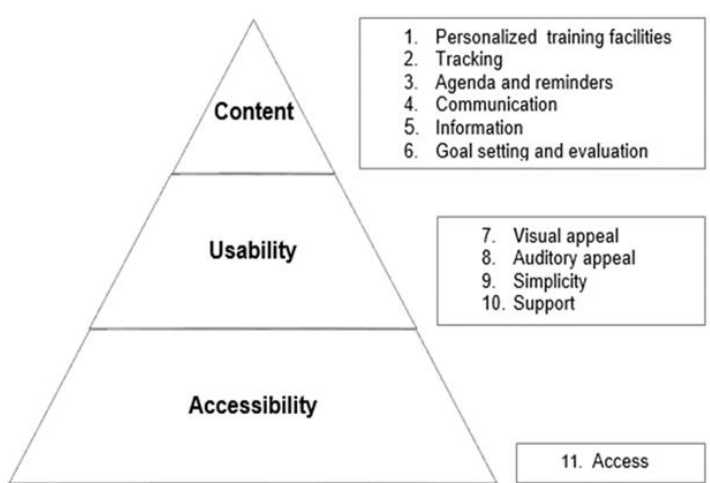
Figure 1. Key themes end-user requirements for e-health interventions in stroke